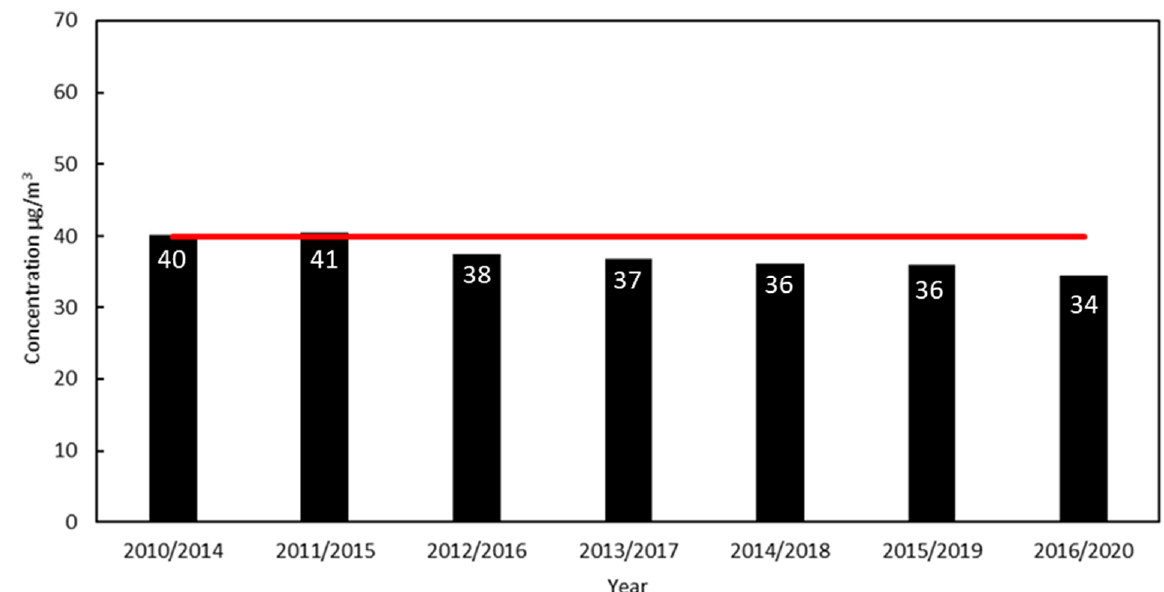
Figure 4. PM10 five-year moving annual average concentrations measured in Milan by the ARPA Lombardia network and PM10 annual law limit of 40 μ g/m 3 according to Lgs. 155/2010 (red solid line).